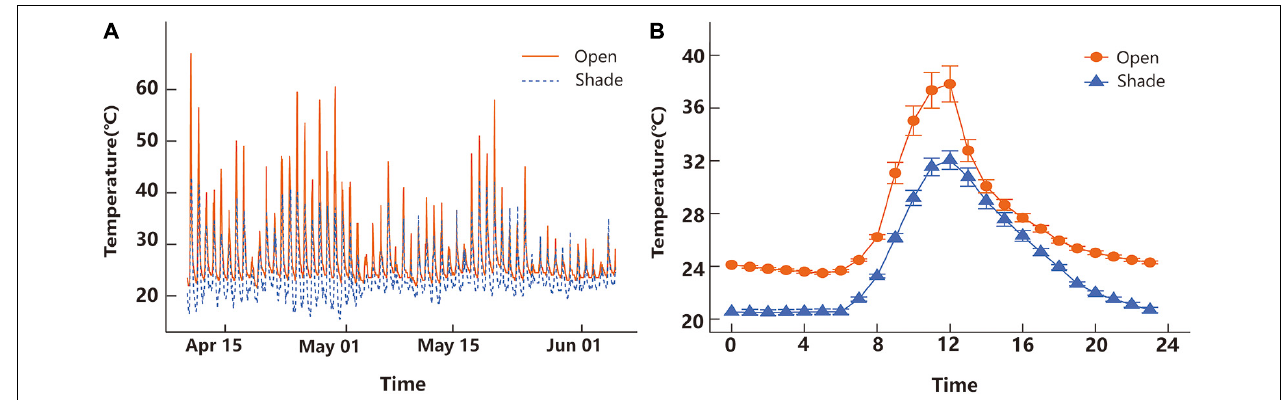
FIGURE 1 | Hourly (A) and daily average (B) operative temperatures (T e ) for high-elevation T. kuehnei in the field. (A) The Orange solid line and blue dash line indicate the T e of open and shade sites, respectively. (B) Orange spots and blue triangles indicate the T e of open and shade sites across the daytime, respectively. Data are shown as mean ± SE.